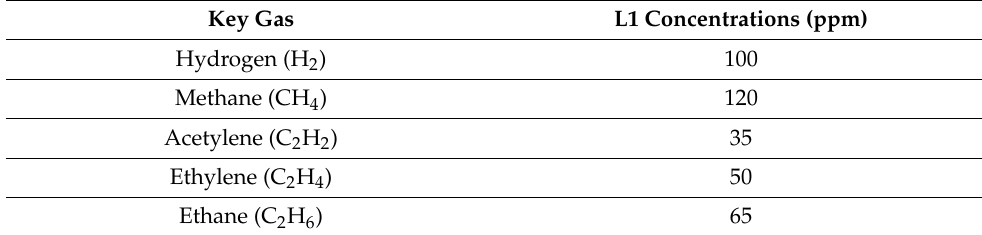
Table 3. Limit (L1) for the Doernenburg-c ratio